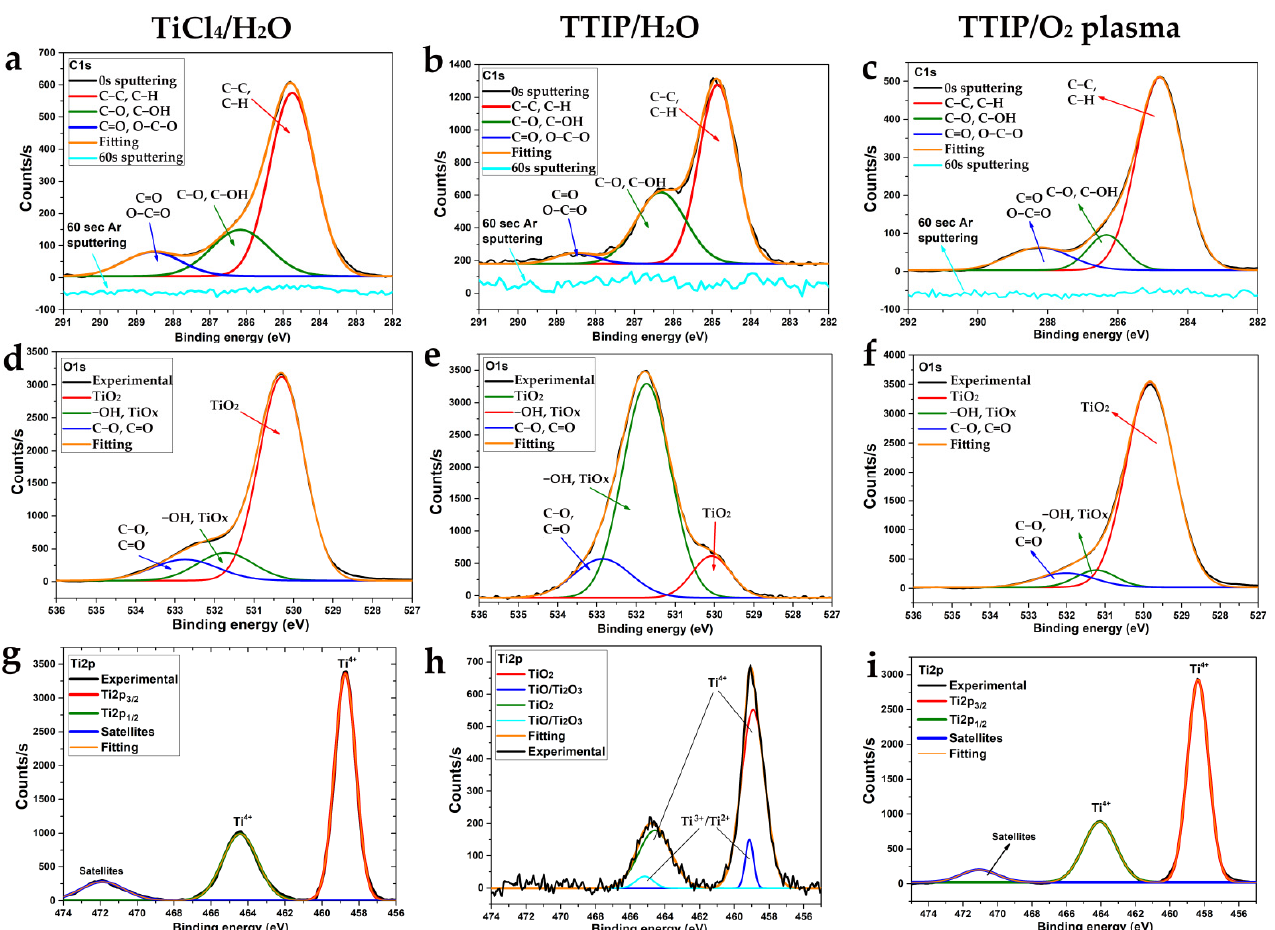
Figure 7. XPS C1s ( a – c ), O1s ( d – f ), and Ti2p ( g – i ) spectra of all studied coatings obtained using TiCl 4 /H 2 O ( a , d , g ), TTIP/H 2 O ( b,e,h ) and TTIP/O 2 plasma ( c,f,i ).